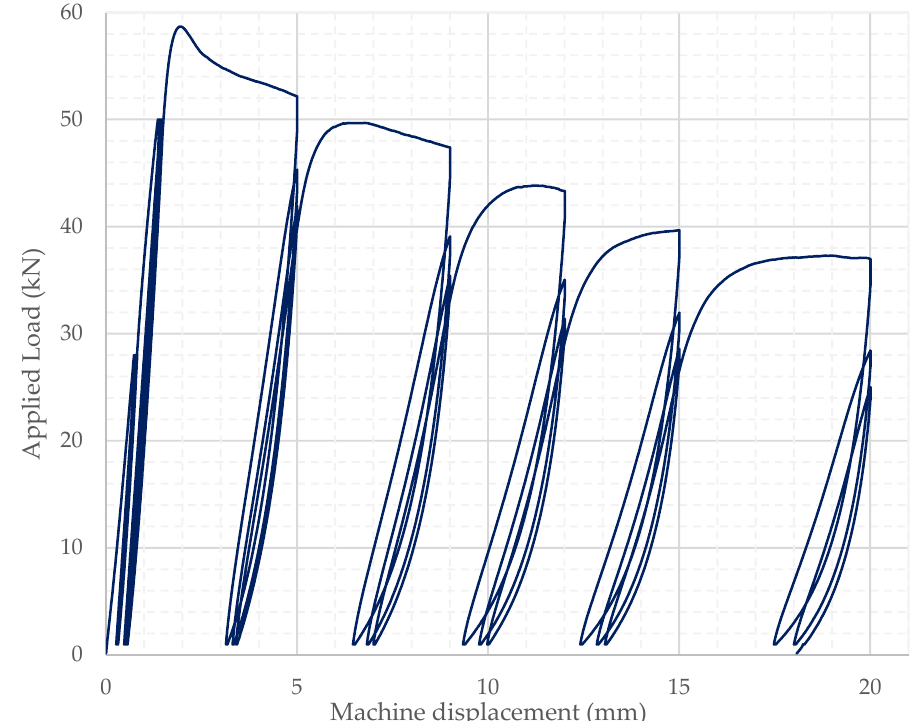
Figure 3. Cyclic loading command path .